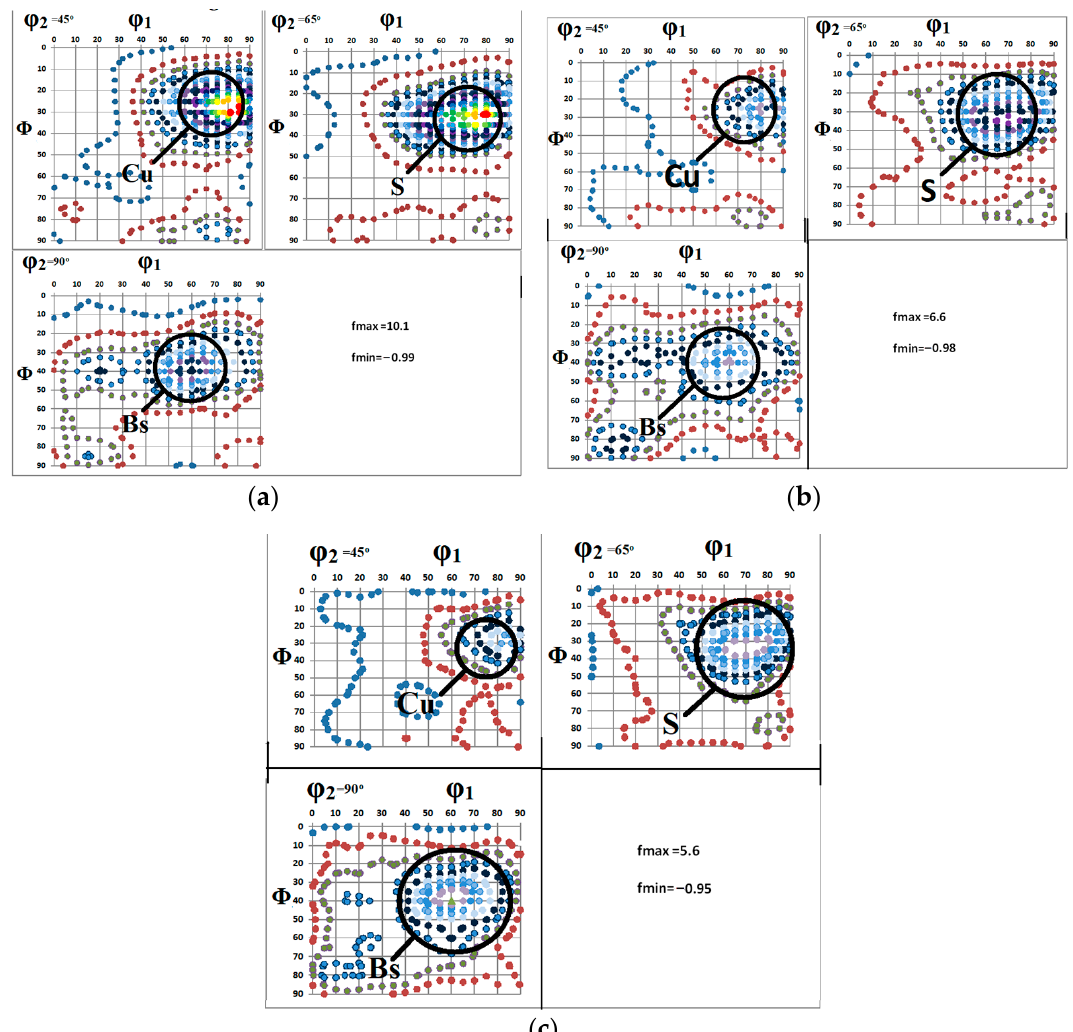
Figure 9. Example of calculated ODF : ( a ) Aluminum 1050; ( b ) AlMg1; ( c ) AlMg4, strain rate 10 s − 1 , temperature 300 ° С .